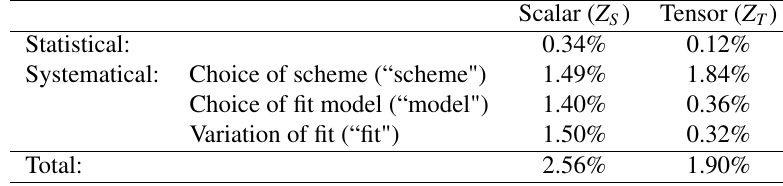
Table 2: The error budget for Z MS intermediate